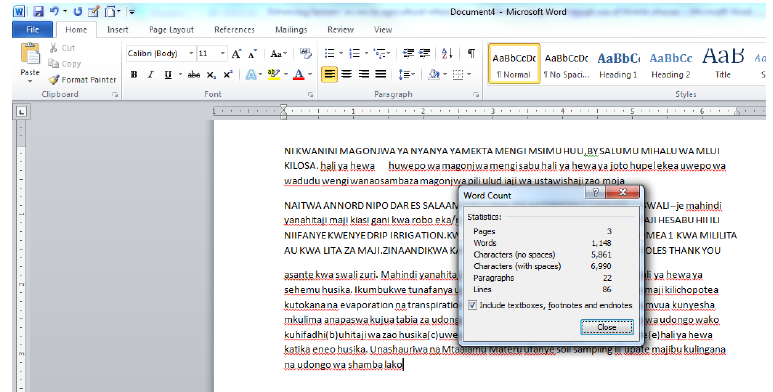
Figure 3. Data cleaning of the results from simple search.